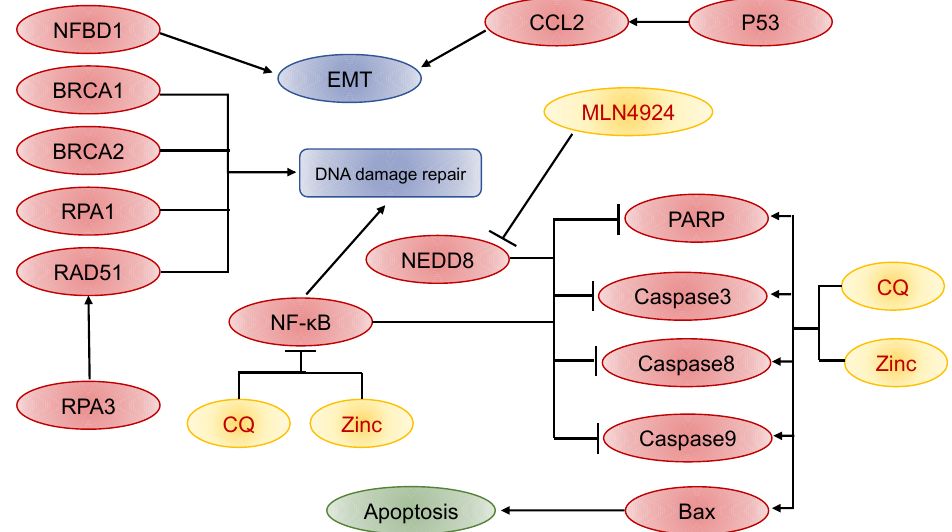
Figure 4. Related molecules and pathways affecting NPC recurrence and progression, such as invasive metastasis and radio resistance.